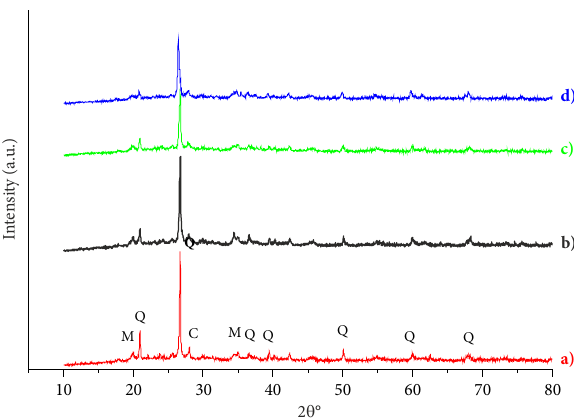
Figure 8. XRD patterns of: a – S0; b – S1; c – S3; d – S5 nanocomposites (M – montmorillonite, Q –